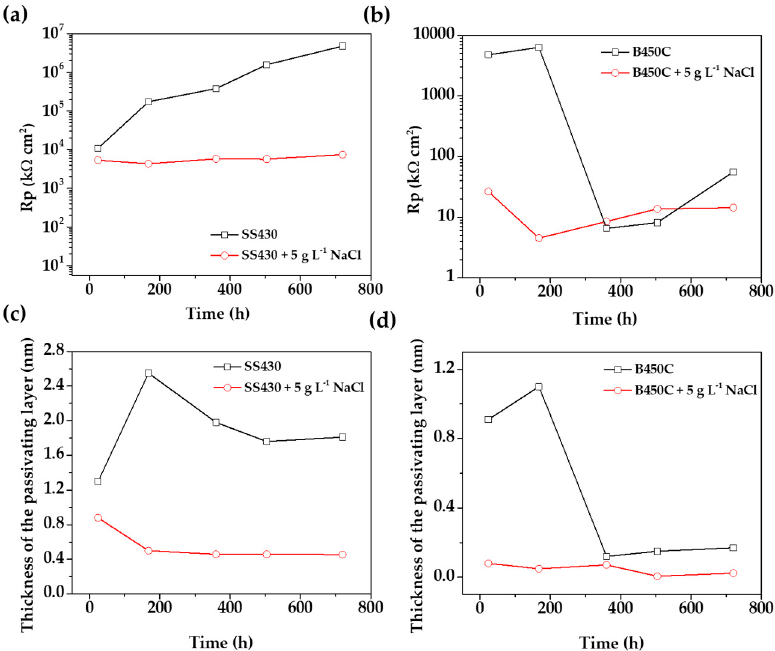
Figure 12. ( a , b ) Evolution of R p values and ( c , d ) passive layer thickness ( d ) during the immersion of SS 430 and carbon steel B450 to cement extract solution in the presence of chloride-containing cement extract solution (this study) and in the absence of chlorides [34].